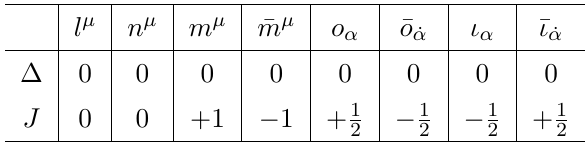
Table 1. SL(2, C ) quantum numbers for the tetrad and spin